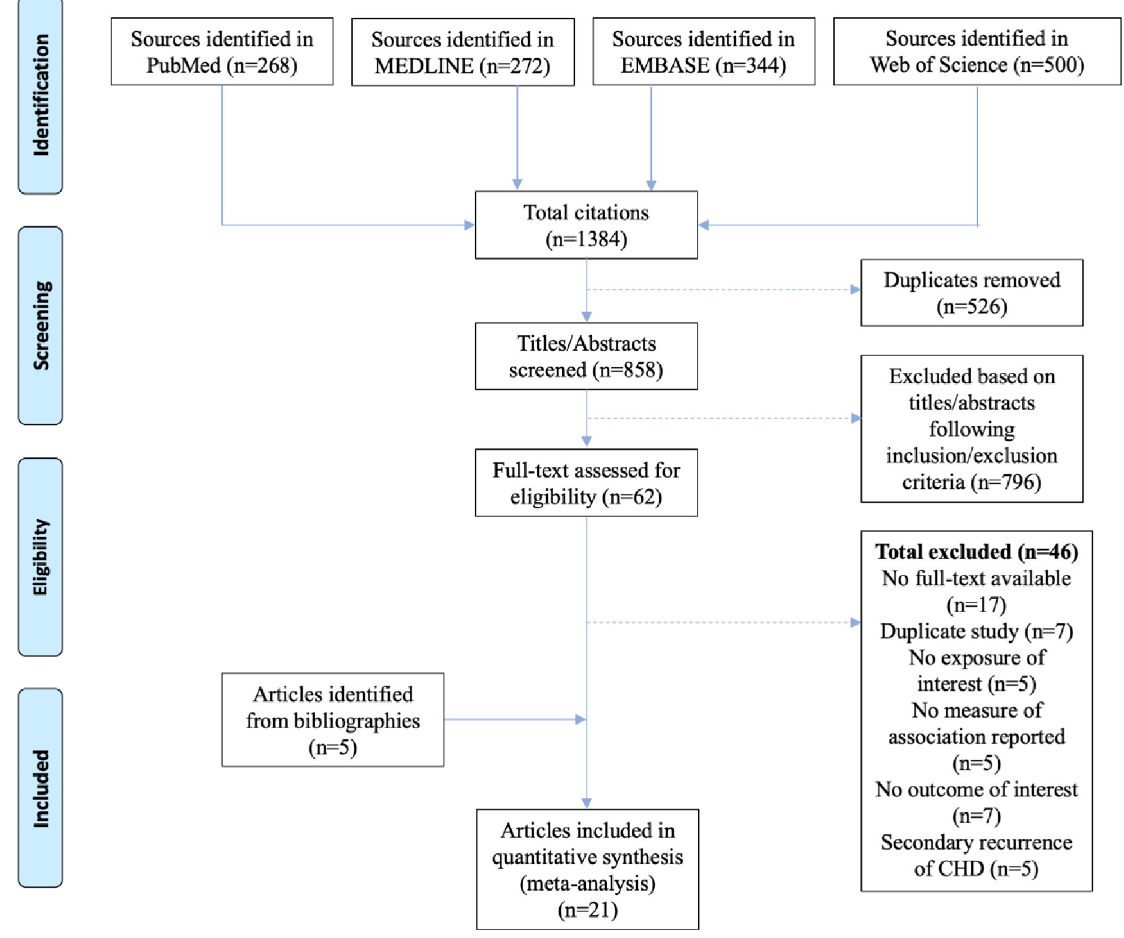
Fig 1. Systematic review PRISMA flow